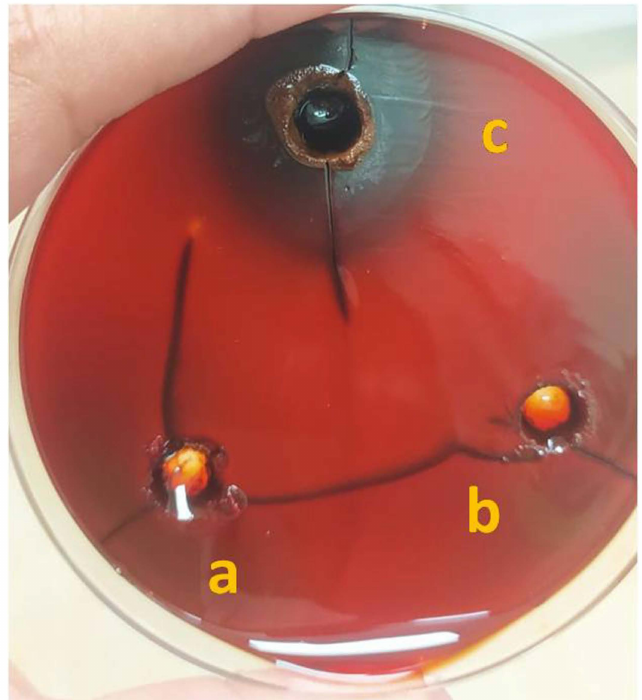
Figure 7. Photograph shows bio-film degradation efficiency of the Zn(OH) 2 /ZnO bionanocomposite using Congored method at a concentration of ( a ) 50 mg/mL ( b ) 75 mg/mLand ( c )